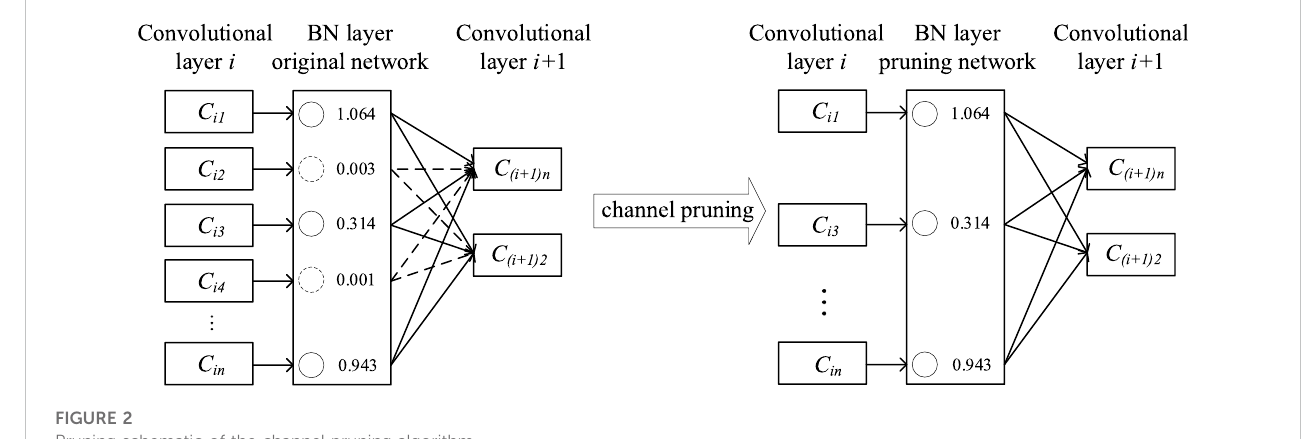
FIGURE 2 Pruning schematic of the channel pruning algorithm.